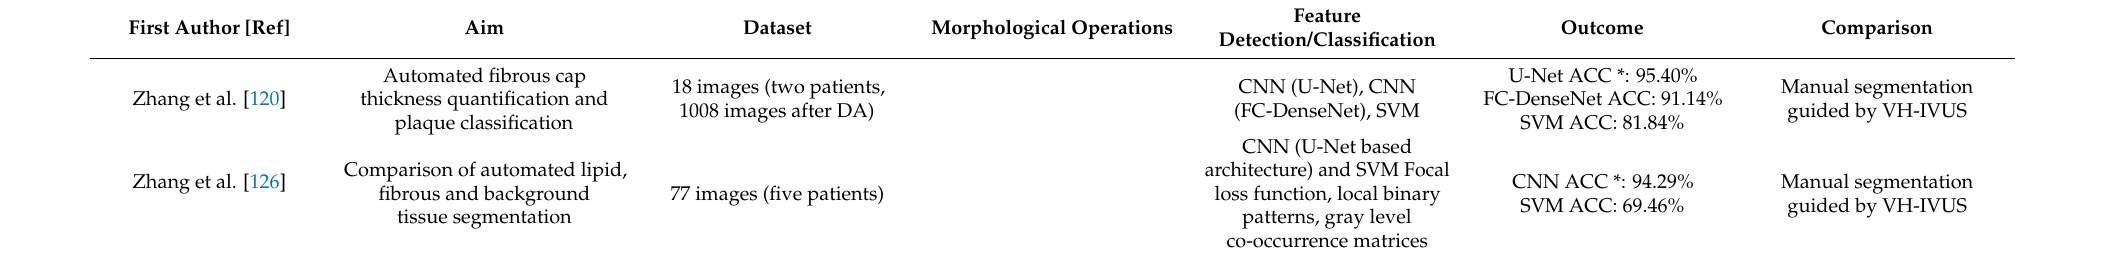
Table A4. Classified articles investigating automated stent segmentation. 3D—Three-dimensional. ADAM—Gradient based adaptive optimization.